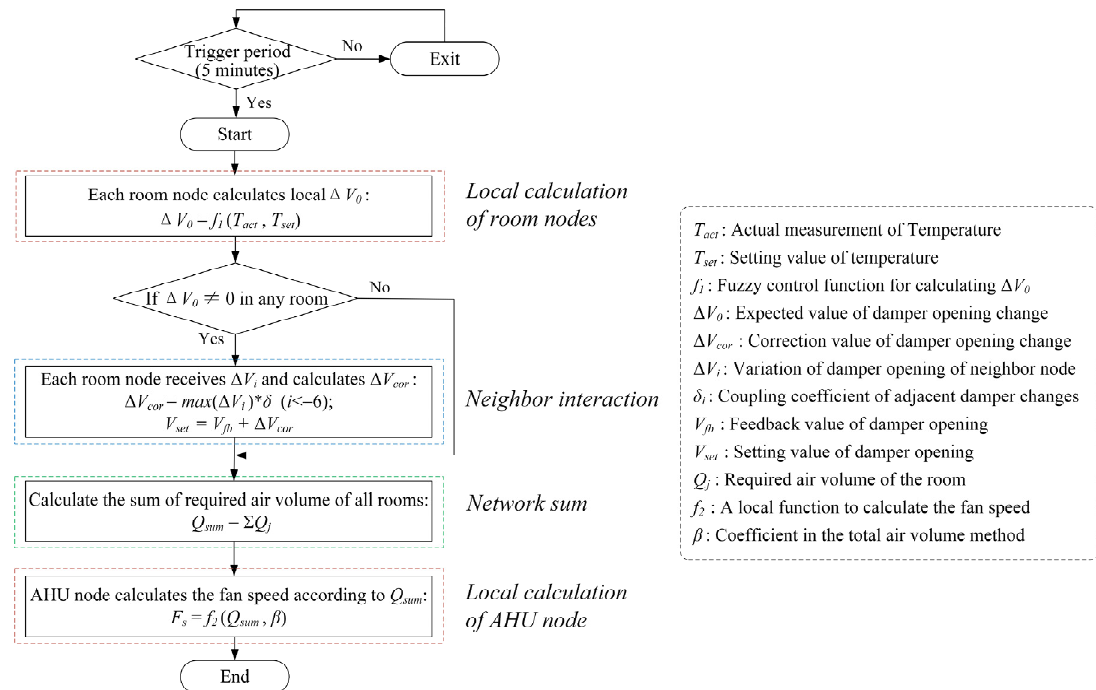
Figure 3. VAV system optimization control algorithm steps.